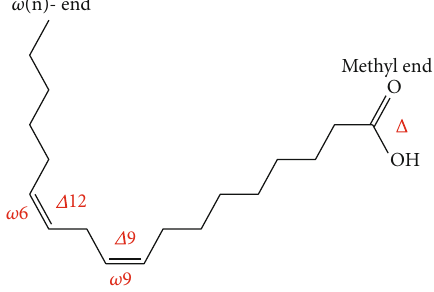
Figure 2: The chemical structure of linoleic acid (LA, 18:2n-6 or 18:2 Δ 9,12 ) and its two alternative systematic nomenclature. LA contains 2 double bonds, or desaturations, at the Δ 9 and Δ 12 carbon positions from the carboxyl ( Δ terminus) or at the n-6 and n-9 carbon positions counted from the methyl (-n) end